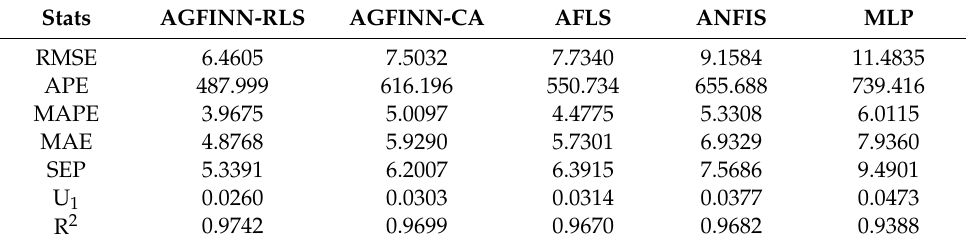
Figure 12. Prediction for electricity price at 04:00—case study 3. Table 5. Statistical performances for electricity price forecasting models at 22:00—case study 3.